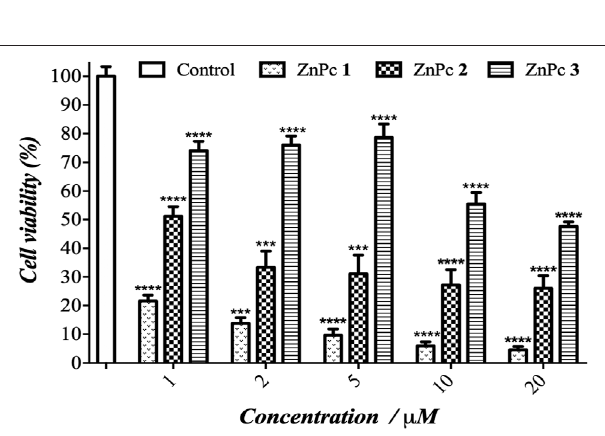
FIGURE 4 | Photocytotoxicity of ZnPcs 1 – 3 against B16F10 cells as a function of PS concentration under red light and applying a light dose of 3 J/ cm 2 . The results are presented as mean ± standard deviation. Statistical signi fi cance:*** p < 0.001and**** p < 0.0001 vs. control.Thecontrolcells without PS were irradiated with the same conditions used in the PDT